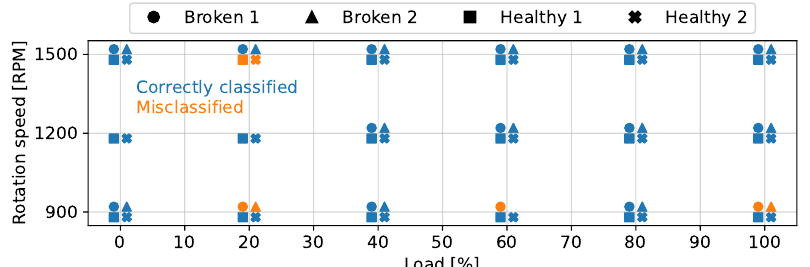
Figure 15. The results of the CB model used with the holdout test dataset, showing which samples with different no-load rotation speeds and loads were classified